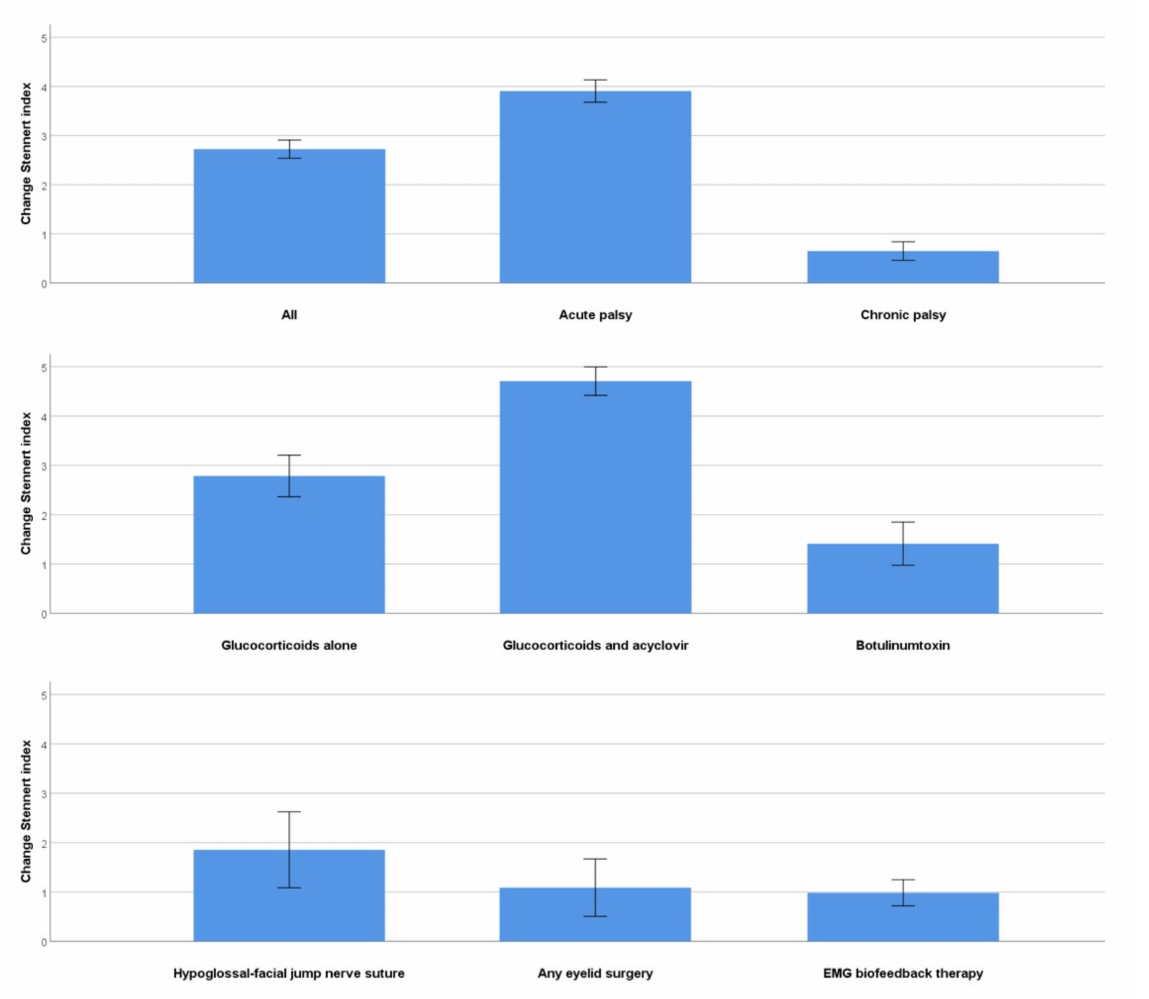
Figure 1. Absolute improvement of facial function between initial and last evaluation in the Facial Nerve Center, assessed with the Stennert index (higher number = more improvement; absolute total Stennert index ranges from 0 to 10). The overall improvement of the complete study for the subgroup of acute versus chronic facial palsy as well as of several important subgroups with different therapy scenarios is